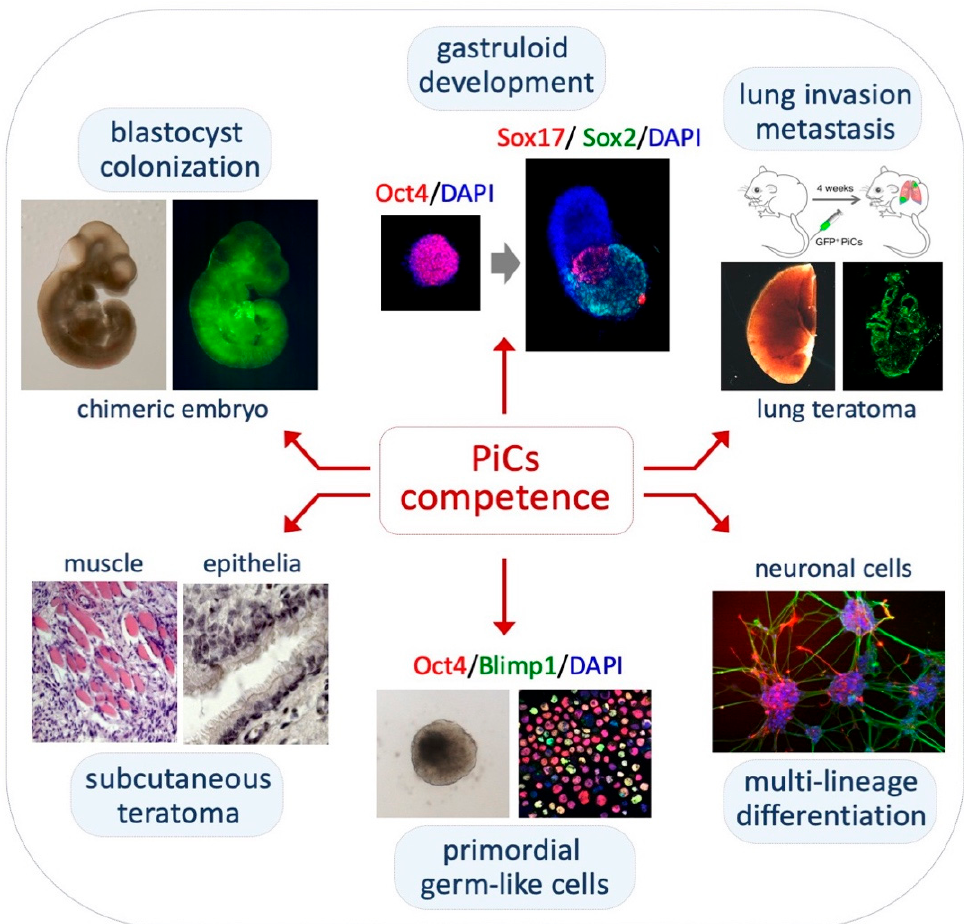
Figure 4. PiC pluripotency in vitro and in vivo. Top left , GFP-positive chimeric embryo (E11.5) generated after the injection of eGFP-labelled PiCs into the blastocyst. Top middle , immunofluorescence staining of Oct4 (red) in PIC-derived spherical aggregates ( left ) and Sox17 (red) and Sox2 (green) in elongated gastruloids. Top right , GFP-positive lung tumor generated after tail vein injection of eGFP-labelled PiCs. Bottom left , hematoxylin–eosin-stained sections of PiC-derived subcutaneous teratomas. Bottom middle , bright-field image ( left ) of PiC-derived aggregates and immunofluorescence staining (right) of Oct4 (red) and Blimp1 (green) on cytospin-fixed cells from PiC-derived aggregates showing the presence of Oct4/Blimp1 double-positive PGCLCs. Bottom right , neural lineage differentiation of PiCs.